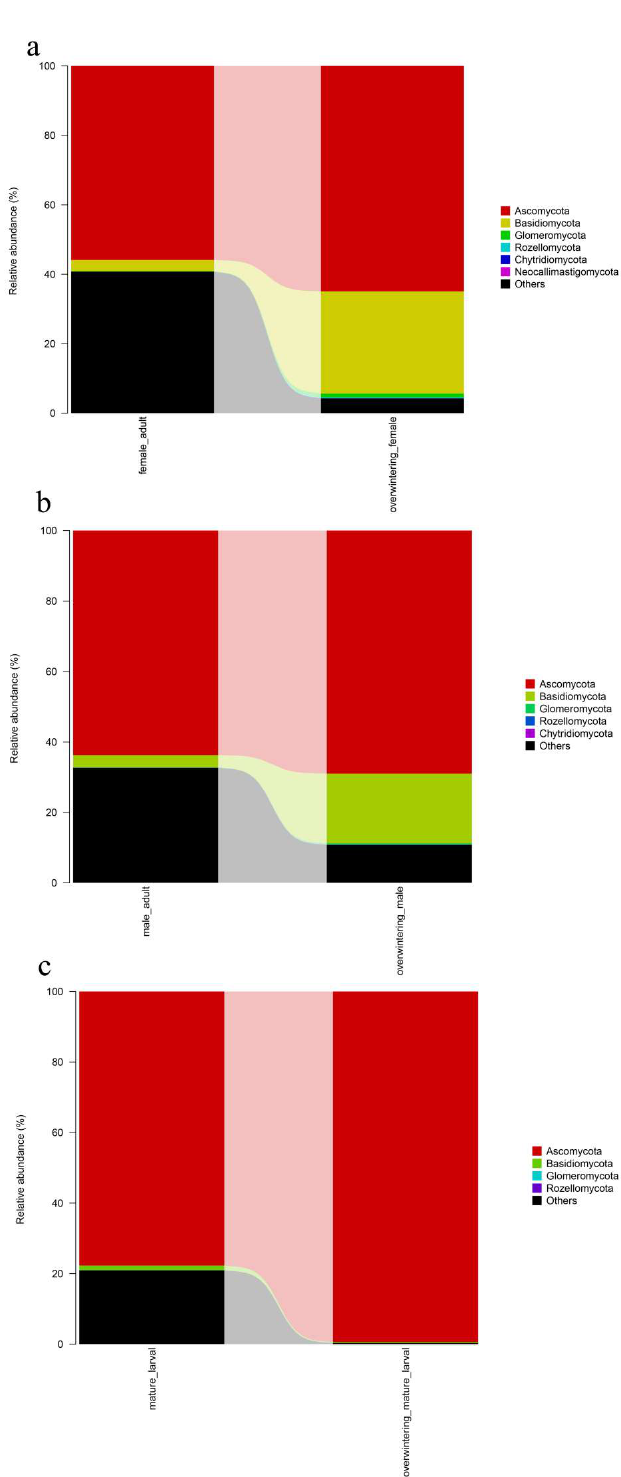
Figure 6. Fungal community structure variation in different generations of T. klimeschi at the phylum level. ( a ) Adult females vs. overwintering adult females; ( b ) adult males vs. overwintering adult males; ( c ) mature larvae vs. overwintering mature larvae.